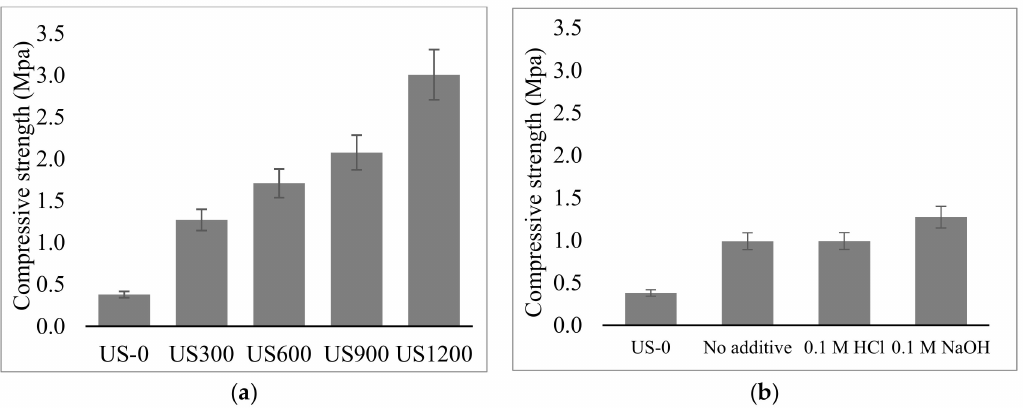
Figure 11. Compressive strength of ( a ) geopolymer from 0.1 M NH 3 US treated soil at di ff erent power. ( b ) geopolymer from the US treated soil with di ff erent